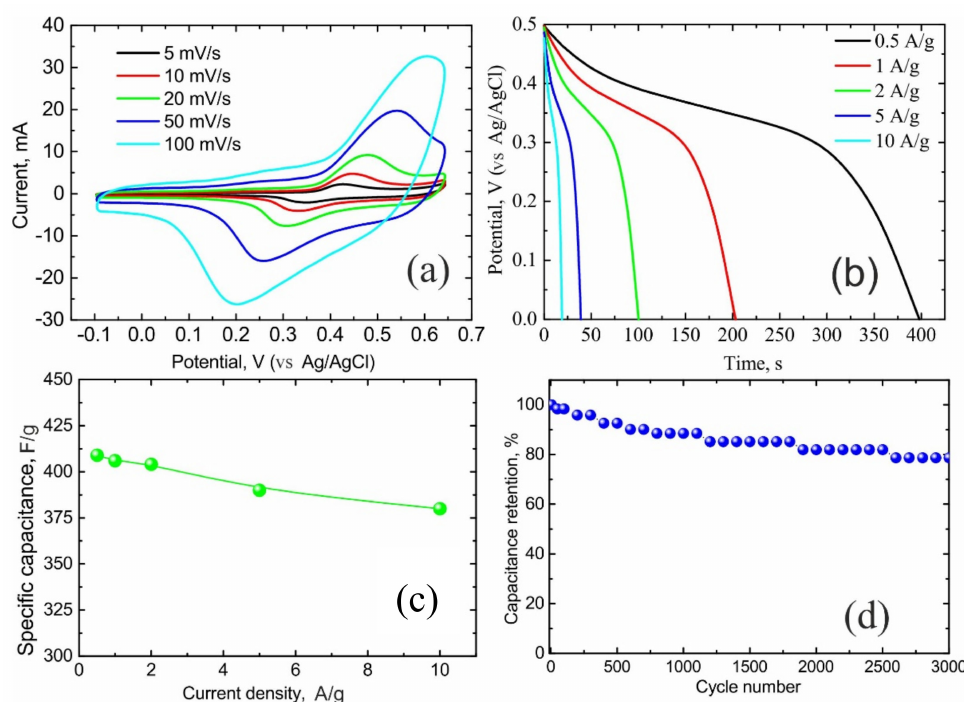
Figure 6. Electrochemical performance of NiO/C nanocomposite (60 wt% NiO) in a three-electrode cell in a 1 M KOH aqueous solution: ( a ) CVs at various scan rates; ( b ) galvanostatic discharge curves at various current densities; ( c ) specific capacitance as a function of current density; ( d ) cycling stability at the current density of 2